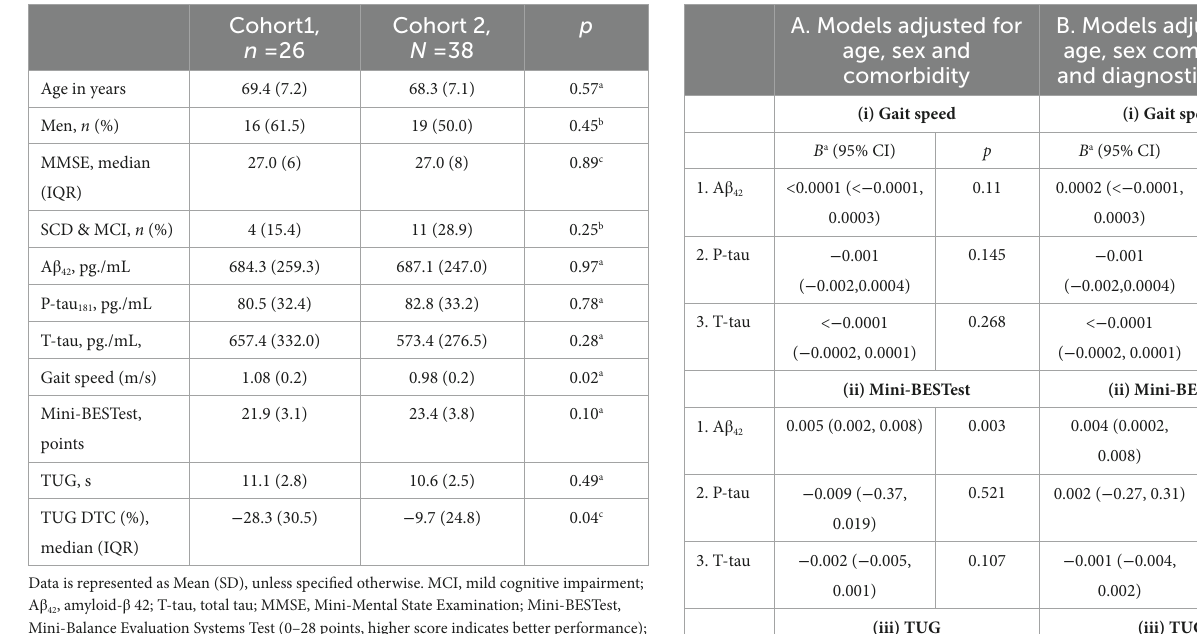
TABLE 2 Comparisons of participants’ characteristics in cohort 1 and cohort 2.